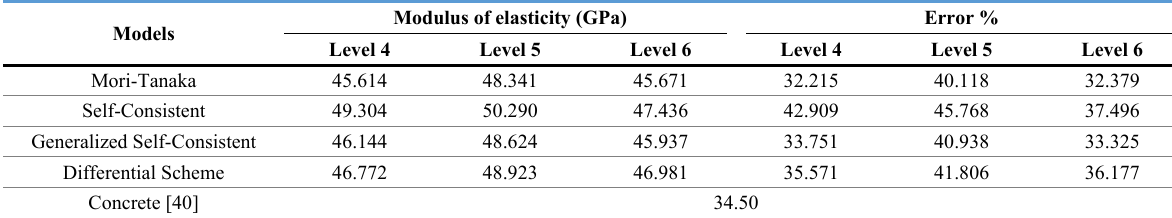
Table 6: Homogenization results for the biphasic models.